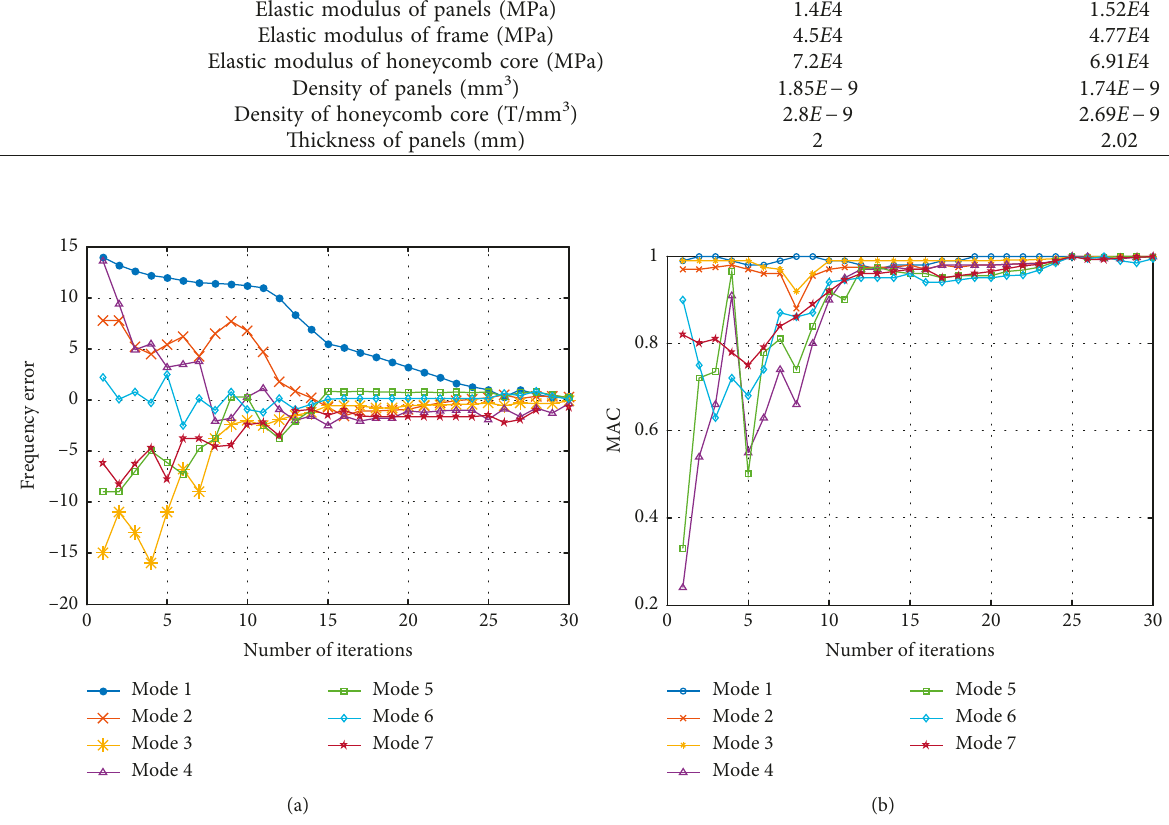
Table 5: Frequency error and MAC value of the model before and after updating.